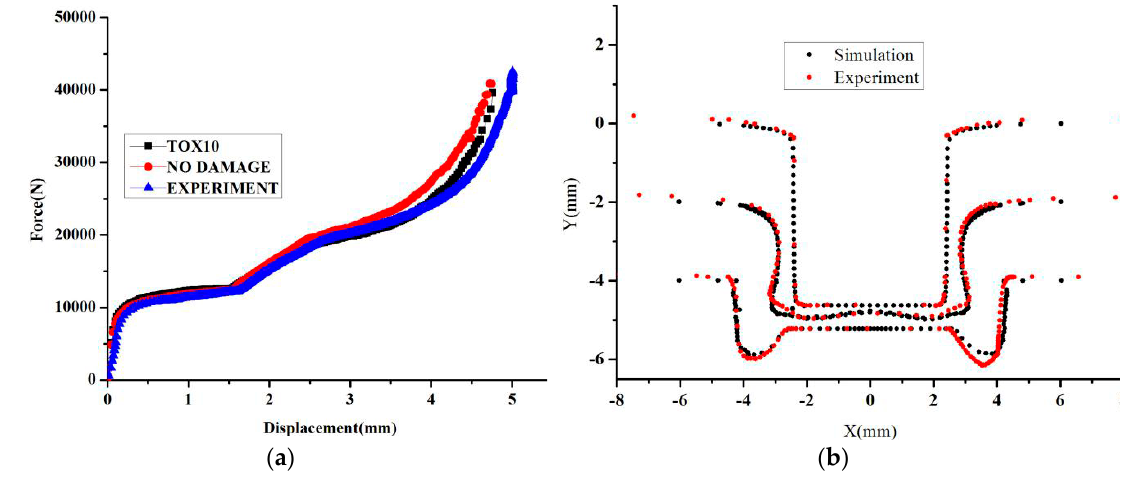
Figure 10. The displacement-load curve and the shape of the clinched joint. ( a ) Deform force; and ( b ) The shape of the clinched joint.